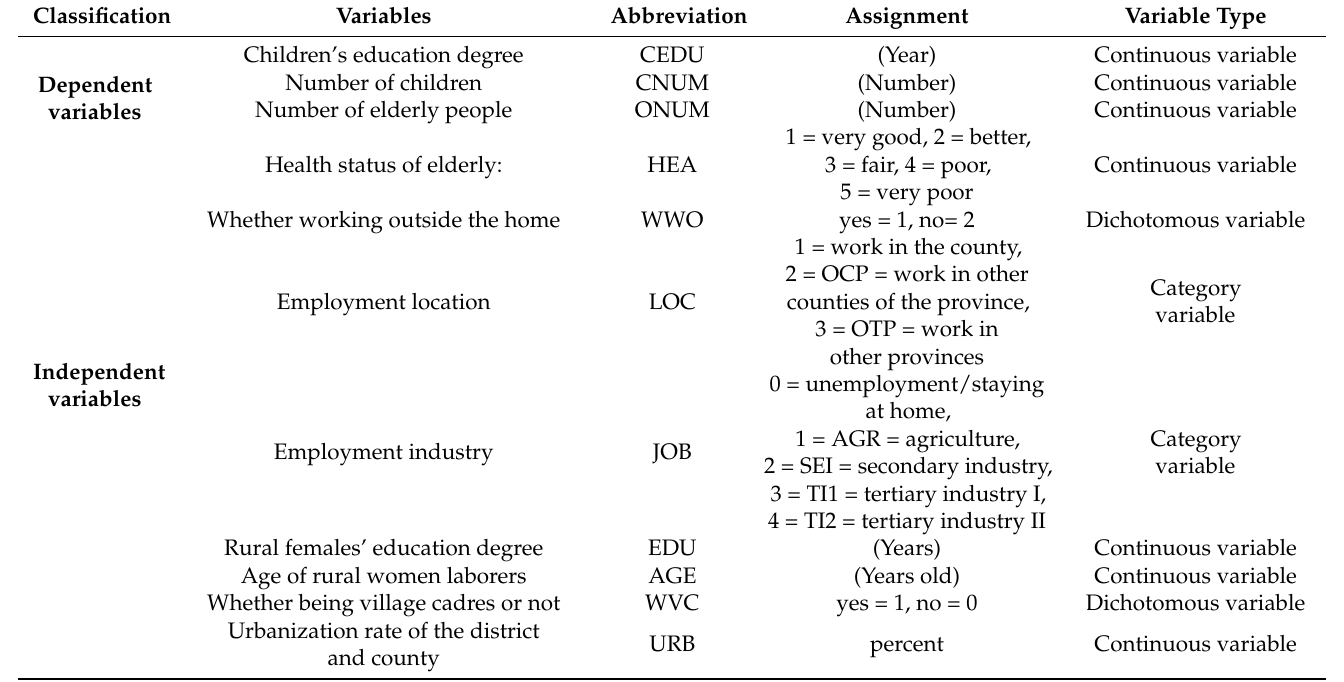
Table 1. Variable